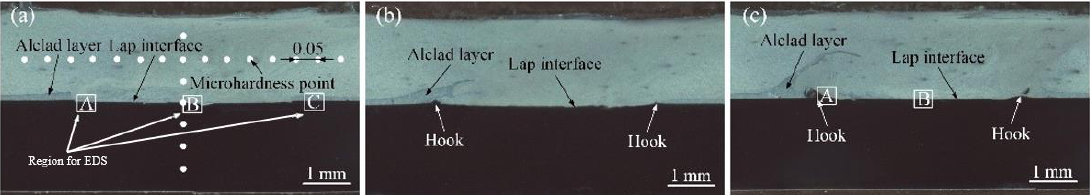
Figure 2. Cross sections of the joints under different rotating speeds: ( a ) 800 rpm, ( b ) 1000 rpm and ( c ) 1200 rpm .